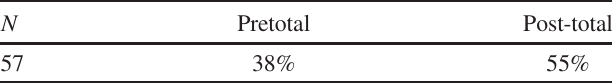
TABLE VI. Average percentage total scores on the pretest